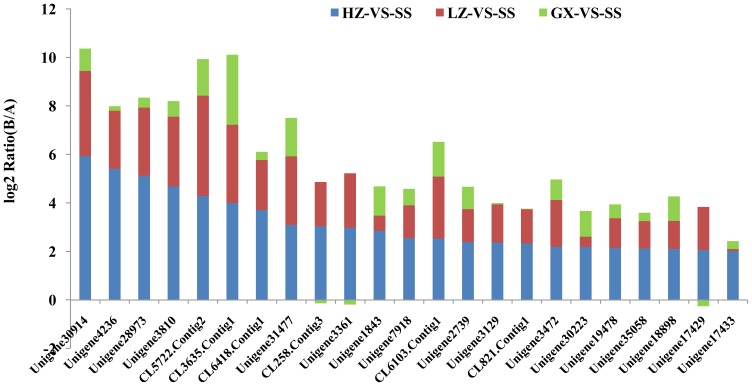
The expression trend and level of genes involved in the metabolic pathways.The metabolic pathways include metabolic pathways, drug metabolism-cytochrome P450, metabolism of xenobiotics by cytochrome P450 and drug metabolism-other enzymes.